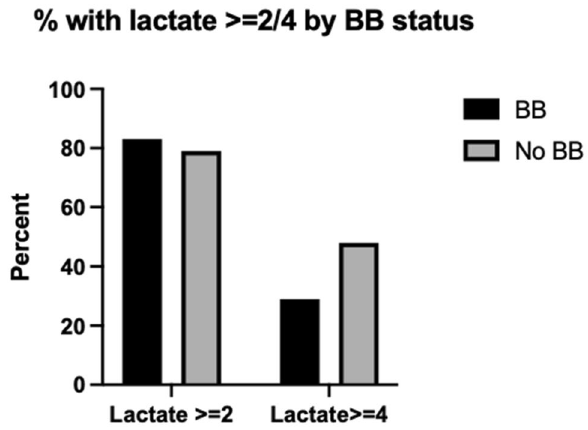
Figure 3. Percentages of those prescribed and not prescribed beta blockers with lactate greater than 2 and 4 mmol/L at presentation.